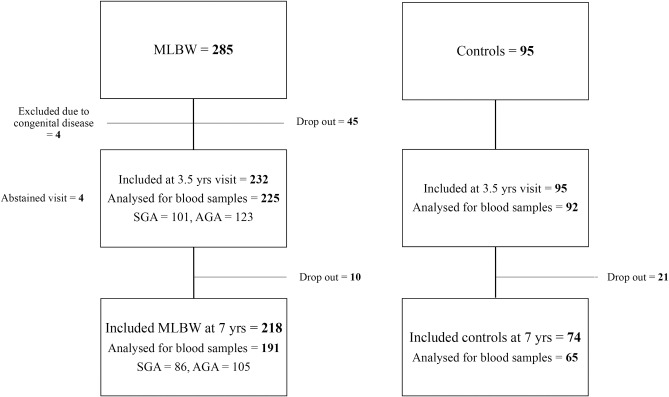
Study flow chart.Study flow chart of 285 marginally low birth weight (marginally LBW) infants and 95 control children born with normal birth weight (NBW). Four infants were excluded due to congenital disorders. Four of the marginally LBW children did not attend the 3.5 year visit but did attend the 7 year visit. The marginally LBW children were also stratified for being born small- or appropriate for gestational age (SGA and AGA respectively).